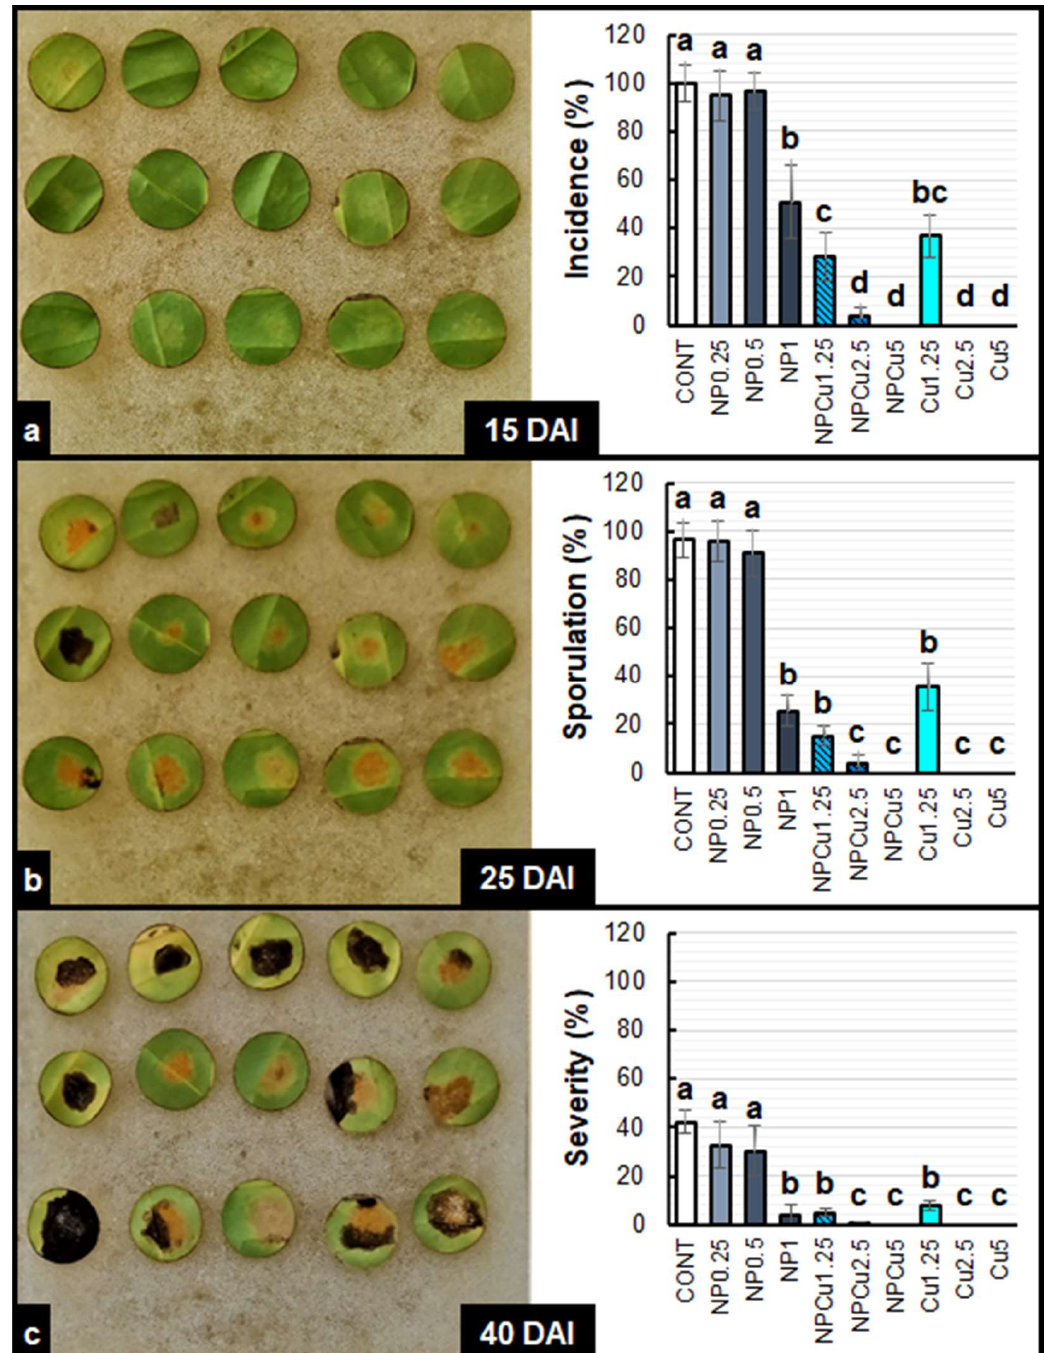
Figure 3. Incidence ( a ), Sporulation ( b ), and severity ( c ) of Hemileia vastatrix disease in leaf discs of Coffea arabica cv. IPR 100 at 15, 25, and 40 days after infection (DAI). Before infection, the discs were treated with distilled water as a control (CONT), chitosan nanoparticles without Cu 2+ ions (NP), chitosan nanoparticles containing Cu 2+ ions (NPCu), and free Cu 2+ ions (Cu). The formulations were diluted in distilled water, obtaining the corresponding concentrations of chitosan (CS) in NP and NPCu treatments (0.25; 0.5; 1 g L −1 ) and of Cu 2+ ions (1.25; 2.5; 5 mmol L −1 ) in NPCu and Cu treatments. Results are expressed as mean ( n = 4) ± standard error. Equal le(cid:308)ers in the columns indicate that there was no significant difference by Dunn test ( p < 0.05).